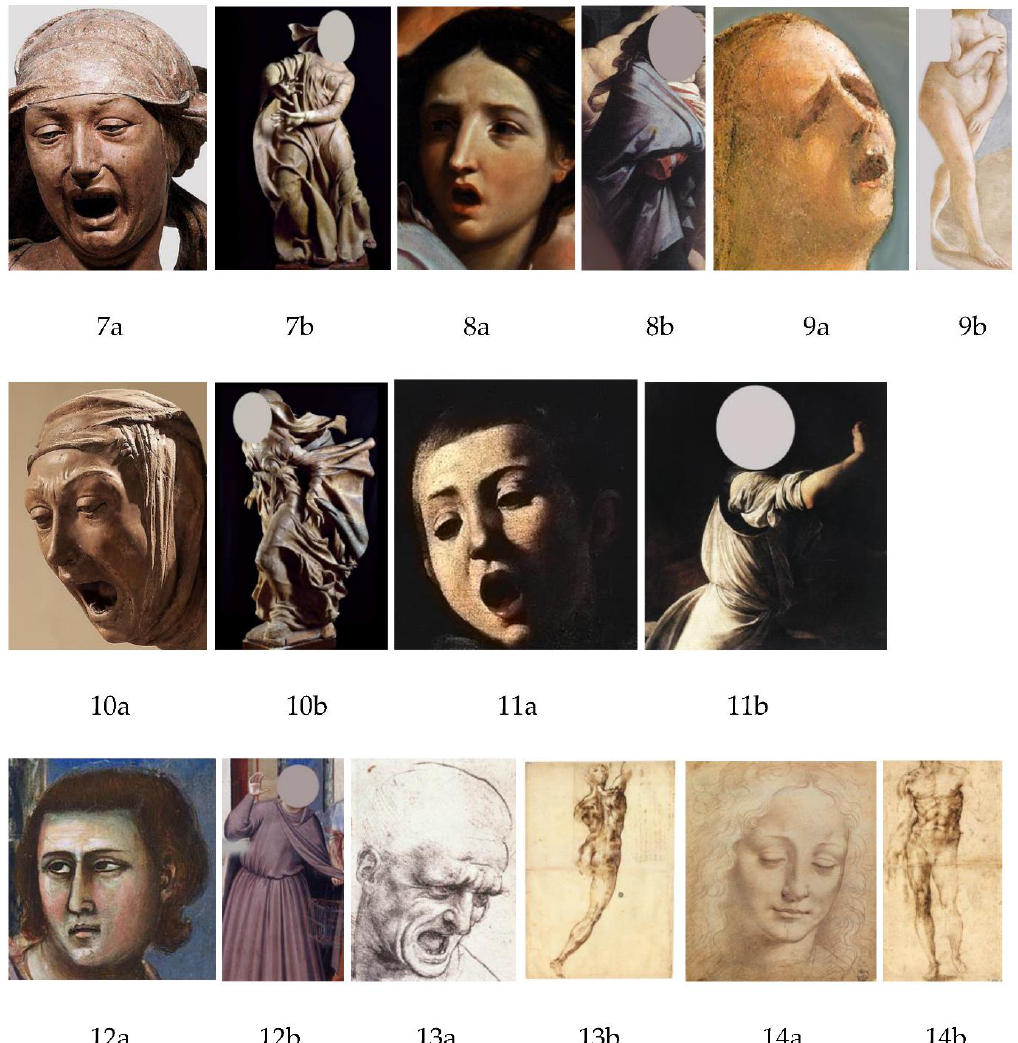
Figure 1. Stimuli used in the experiment. 1. Head ( a ) and body ( b ) taken from Michelangelo Merisi da Caravaggio, Amor vincit omnia , 1602–1603, Berlin, Staatliche Museen. 2. Head ( a ) and body ( b ) taken from Eugène Delacroix, Orphan girl at the cemetery , 1824, Paris, Louvre Museum. 3. Head ( a ) and body ( b ) taken from Giotto, The mourning of Christ , 1303–1305, Padua, Scrovegni Chappel 4. Head ( a ) and body ( b ) taken from Michelangelo Merisi da Caravaggio, Boy bitten by a lizard ,